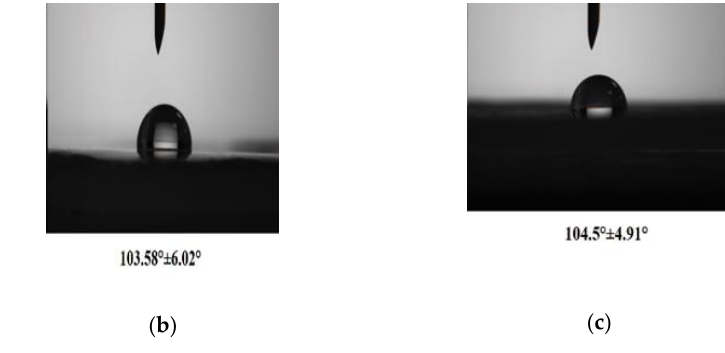
Figure 3. Water contact angle of different films: ( a ) GF; ( b ) GBF; ( c ) GBMF.